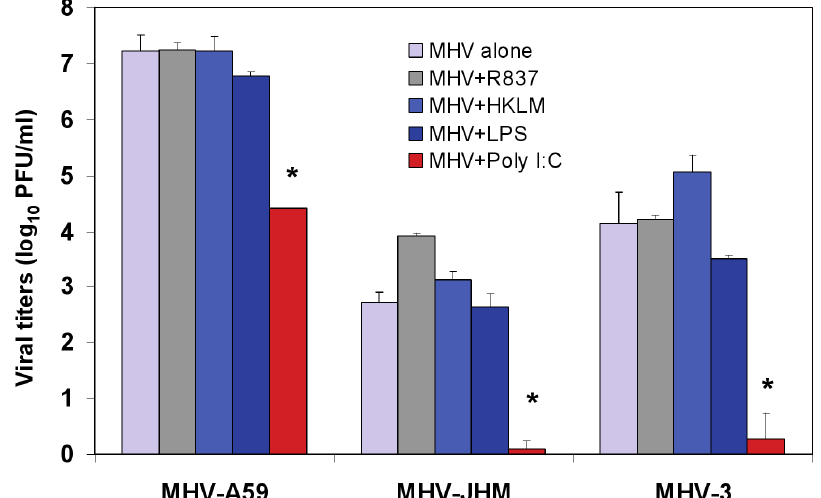
Figure 3. Effect of triggering TLR2, TLR3, TLR4, and TLR7 on virus production in MHV-infected J774A.1 macrophages. J774A.1 cells were prestimulated with TLR ligands for 6 h, infected with MHV-A59, MHV-JHM or MHV-3 (1 MOI) by adsorption for 1h in the absence of the ligands, and activated for up to 18 h p.i. with the appropriate TLR agonist. TLR ligands were used as follows: HKLM (TLR2) at 10 8 cells/mL; LPS (TLR4) at 5 μ g/mL; Imiquimod (R837) (TLR7) at 5 μ g/mL. Poly I:C (TLR3) was tested at a range of concentrations (0.25, 0.5, and 1.0 μ g/mL). Because poly I:C triggered a comparable effect on MHV production at all concentrations (data not shown), viral titers at 0.25 μ g/mL were included in the plot. Cells incubated with the basal medium before and during infection served as a negative control for the effect of TLR triggering on virus production. MHV titers were assessed in cell-free supernatants using a plaque assay on L2 fibroblasts. The data shown are the mean viral titers of three independent experiments, each done